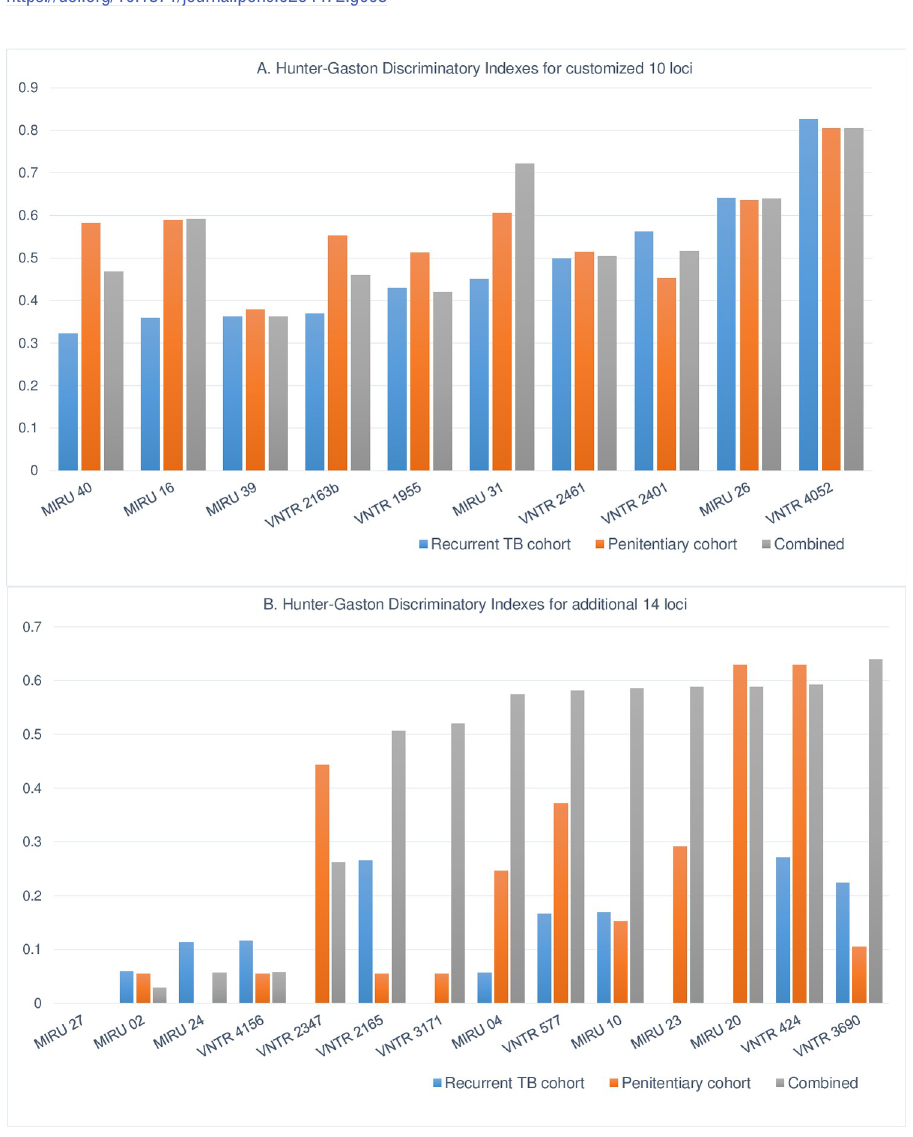
Fig 4. Individual locus HGDI of 10 customized and additional 14 loci. (A) HGDI calculated for the customized 10 loci and (B) the additional 14 loci, based on typing of recurrent TB cases (civil cohort) in blue bars along with same indexes calculated within penitentiary system samples in orange. Grey bars indicate indexes calculated from combined datasets with 24 loci typing. Category definition: HGDI � 0.6 high discriminatory power, 0.3 � HGDI � 0.6 moderate discriminatory power, HGDI < 0.3 low discriminatory